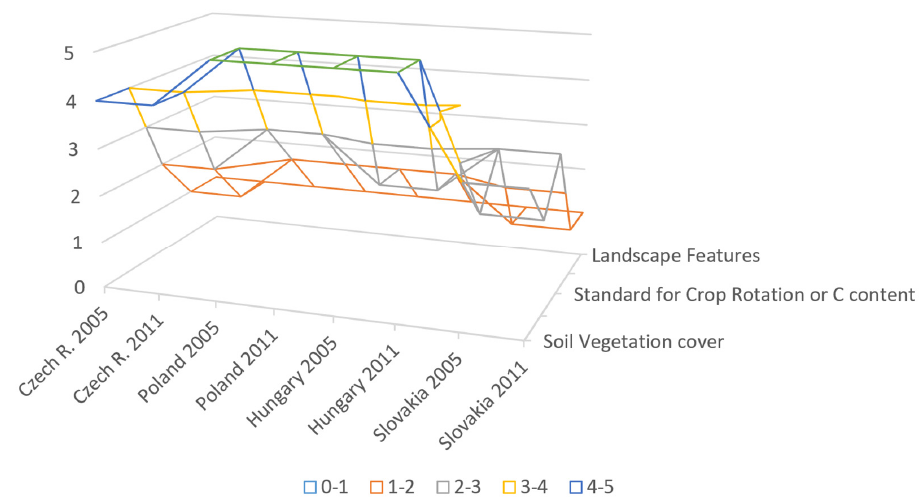
Figure 2. Effectiveness of the requirement in the prevention of the issue outlined by GAECs. Note: 1, most influential; 5, least influential.